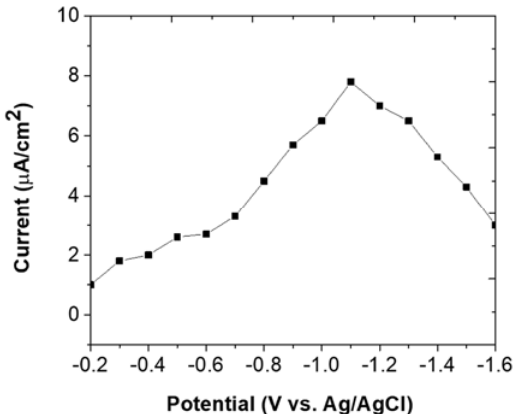
Fig. 9. Effect of accumulation potential on the electrochemical response of butachlor at Pd@MWCNTs; accumulation time 80 s; pulse amplitude 30 mV; scan rate 50 mV s -1